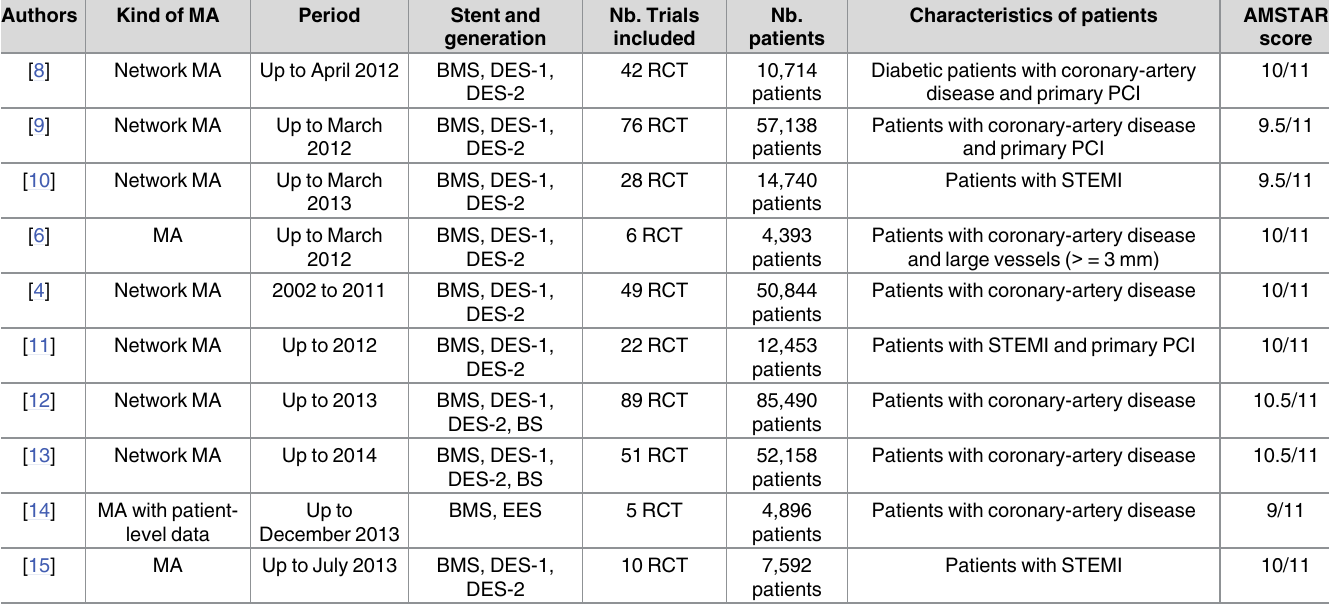
Table 1. Characteristics of meta-analyses